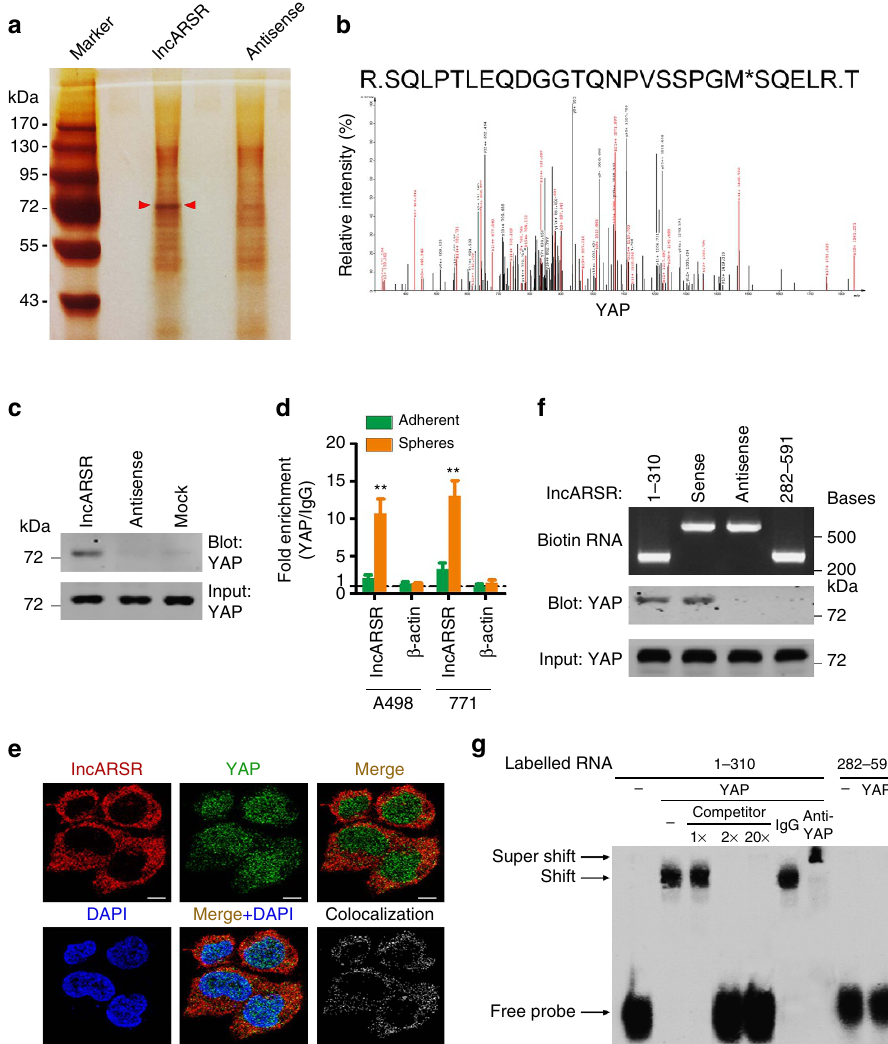
Figure 4 | lncARSR physically interacts with YAP. ( a ) RNA pull-down assays were performed with cytoplasmic lysates of RCC spheres using full-length lncARSR and antisense RNA probes, followed by mass spectrum. Red arrows indicate target band. ( b ) MS/MS profiles of target band (corresponding peptide sequences of YAP) retrieved by lncARSR. ( c ) Western blot analysis of YAP in RNA pull-down precipitates retrieved by biotin-labelled lncARSR or antisense RNA from the cytoplasmic lysates of RCC spheres. ( d ) RIP assay of the enrichment of YAP on lncARSR relative to IgG in the cytoplasmic lysates of adherent and spheres RCC cells ( n ¼ 3). b -action acted as a loading control. Data are represented as mean ± s.d.; ** P o 0.01; two-tailed Student’s t -test. ( e ) RNA FISH analysis of lncARSR (red) and immunofluorescence detection of YAP (green) in A498 spheres. The rightmost graph shows the co-localized signals between the red signal (lncARSR) and the green signal (YAP). Pearson’s correlation: R ¼ 0.658382. Scale bar, 10 m m. ( f ) Upper: gel electrophoresis of in vitro transcribed biotin-labelled RNA of full-length and truncated lncARSR. Lower: western blot analysis of YAP in RNA pull-down precipitates retrieved by different fragments of lncARSR probe. ( g ) RNA EMSA assays of the interaction of different fragments of lncARSR and YAP. Biotin-labelled RNA containing nucleotides 1–310 or 282–591bp of lncARSR acted as probes. Non-labelled RNA probes acted as competitors. Anti-YAP antibody acted for super-shift experiment. ‘Shift’ indicates the shift in mobility induced by the biotin-labelled RNA probe and YAP complex. ‘Super-shift’ indicates the super- shift in mobility induced by the biotin-labelled RNA probe, YAP and anti-YAP antibody